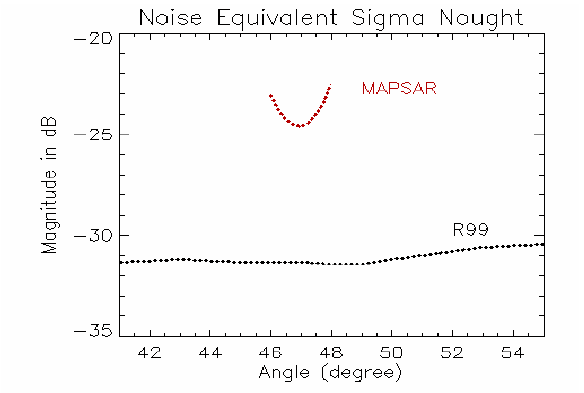
Figure 7 . Plots of estimated NESN for the MAPSAR and the R99B system (HH